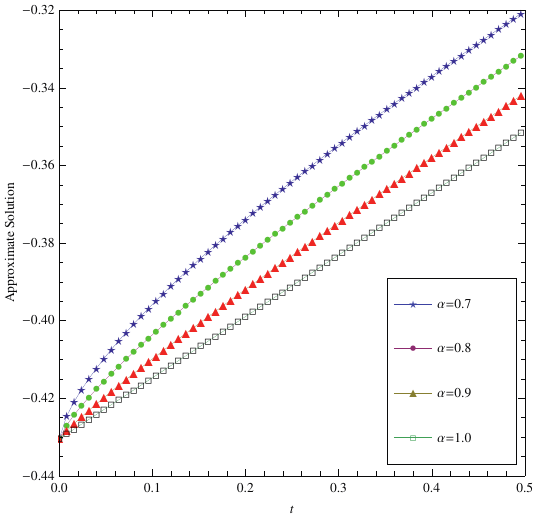
Fig. 3: Plot of u 4 ( x , t ) vs. time t at x = 1 and different value of α . Table 1: The absolute error in the solution of time fractional STO equation using MHATM at different points of x and t when α = 1 .